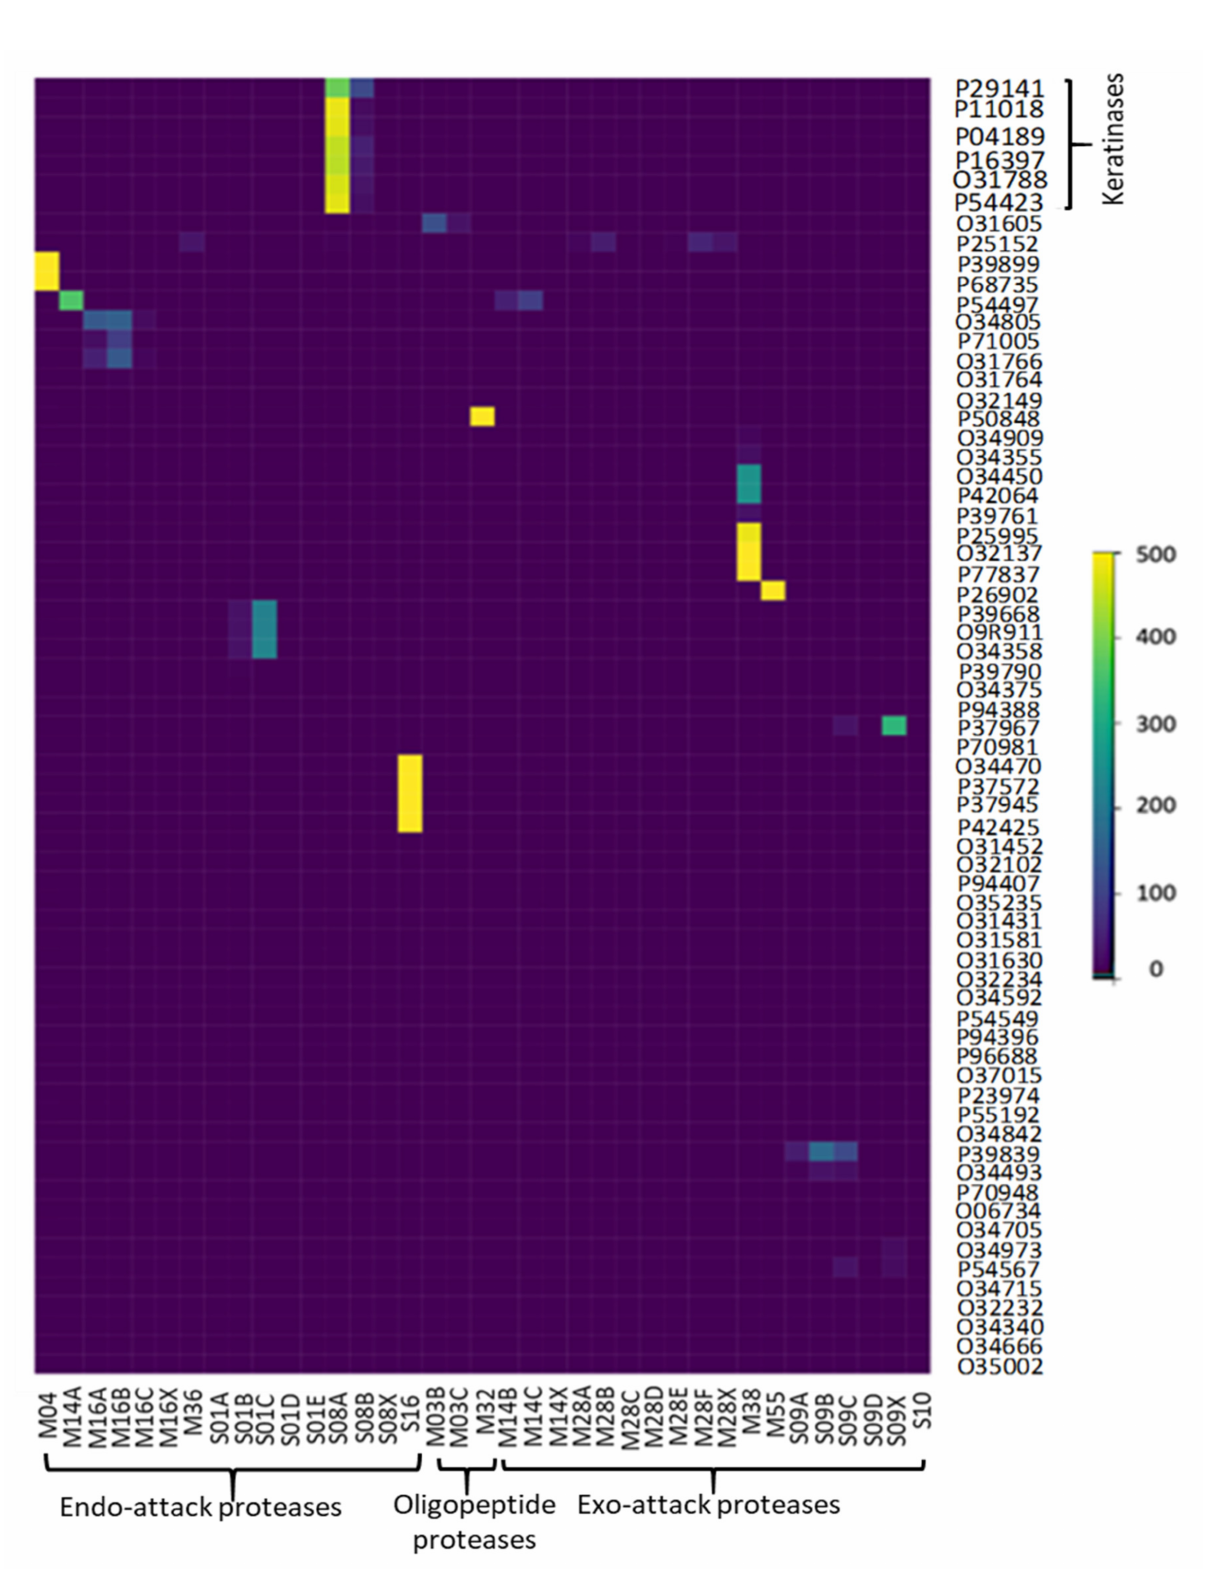
Figure 5. Detected proteases of B. subtilis (strain